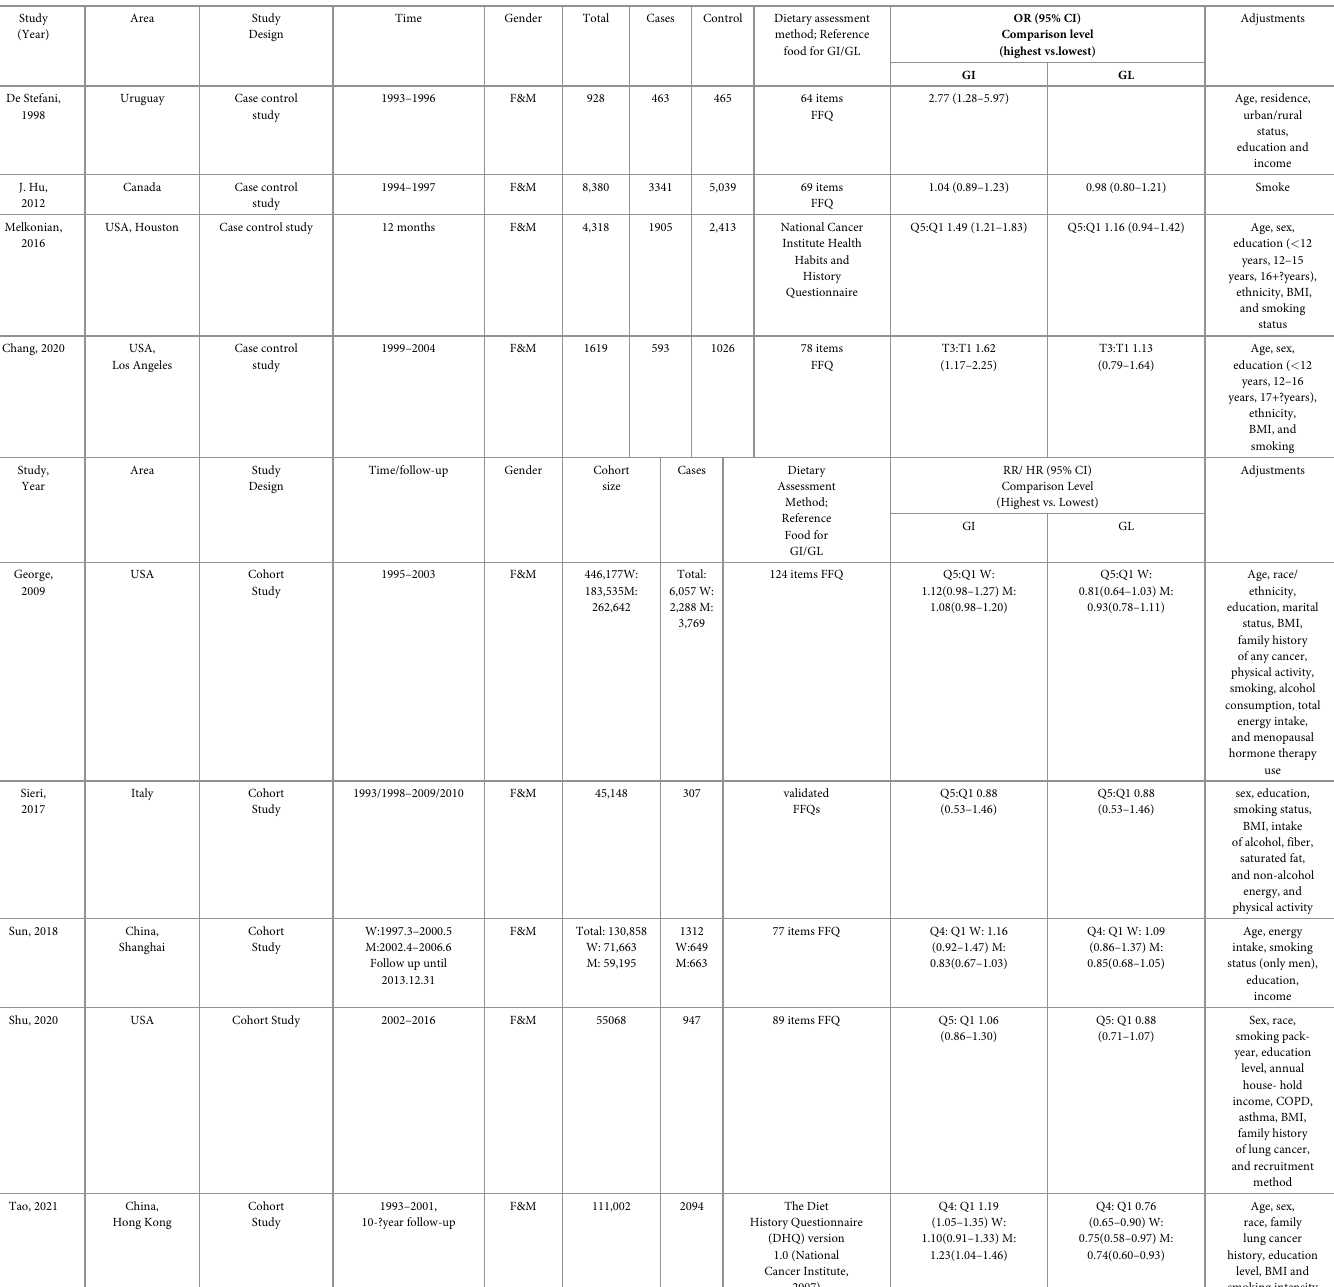
Table 1. Main characteristics of previous studies examined the association of GI, GL, and lung cancer